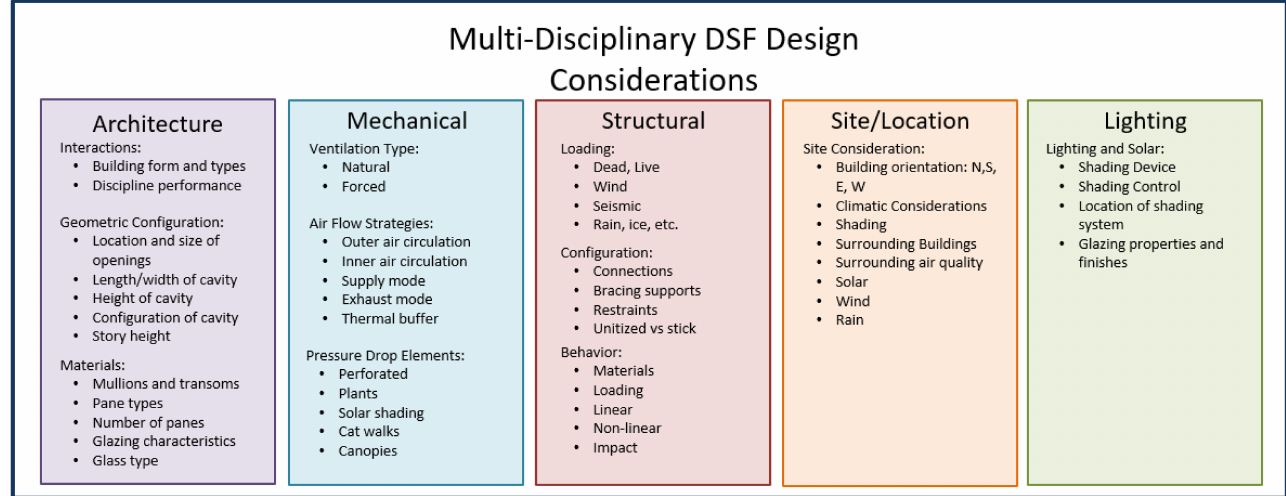
Figure 7. Representative SAP2000 model with locations of possible load